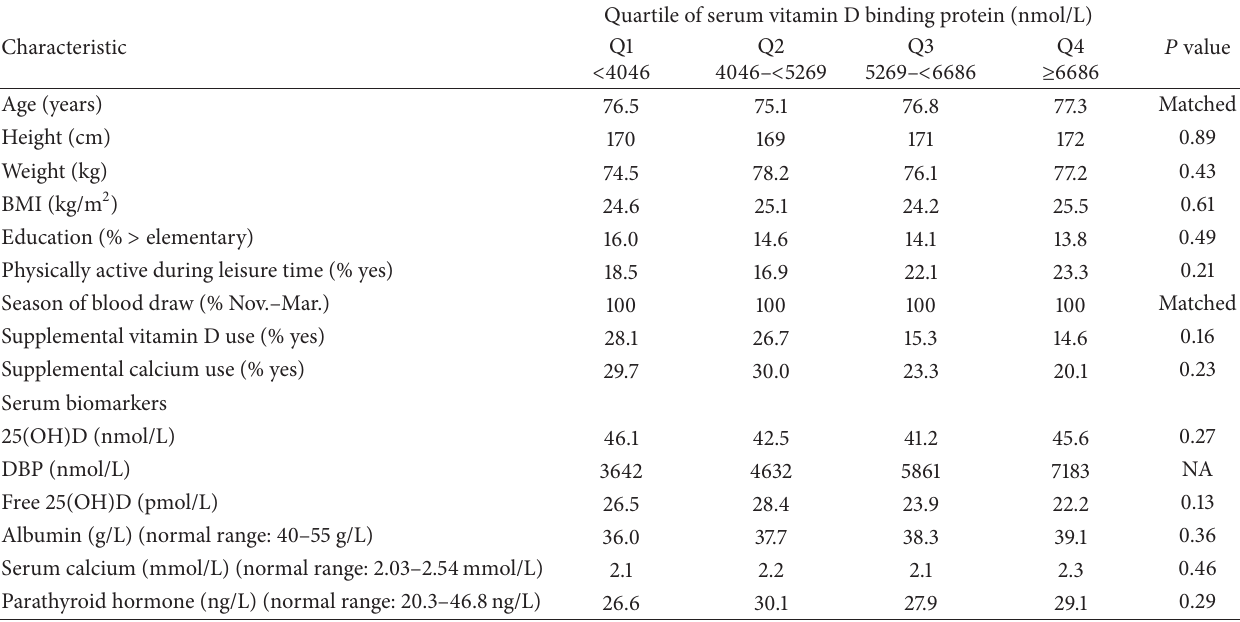
Table 1: Elected baseline characteristics across quartiles of vitamin D binding protein (medians or proportions).